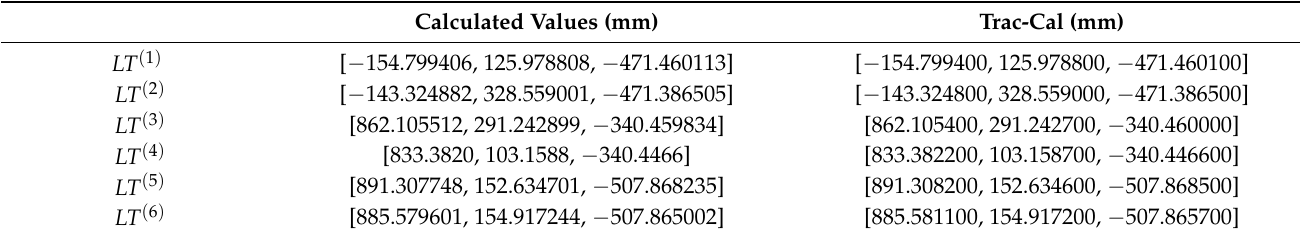
Table 5. Calculated LT positions for Case A with function (7).